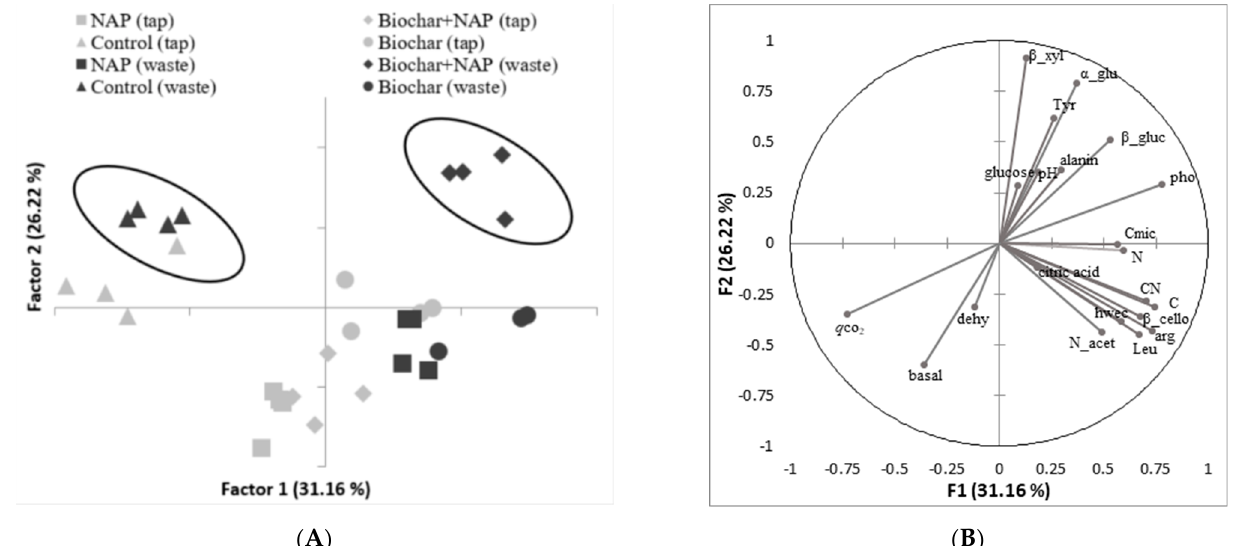
Figure 4. Score plot ( A ) and factor loading ( B ) after varimax rotation with explained variance of components in parentheses (F1: 31.16 and F2: 26.22). Calculated Kaiser–Meyer–Olkin (KMO) index was 0.591. β -xylosidase ( β _xyl), α -glucosidase ( α _glu), Tyr (tyrosine-aminopeptidase), β _glu ( β -glucosidase), pho (acid phosphatase), dehy (dehydrogenase), N acet (N-Acetyl- β -glucosaminidase), Leu (leucine-aminopeptidase), arg (arginine-aminopeptidase), N (nitrogen), C (carbon), CN (C: N), HWEC (hot water extractible carbon), Cmic (microbial biomass carbon), q CO 2 (metabolic quotient).